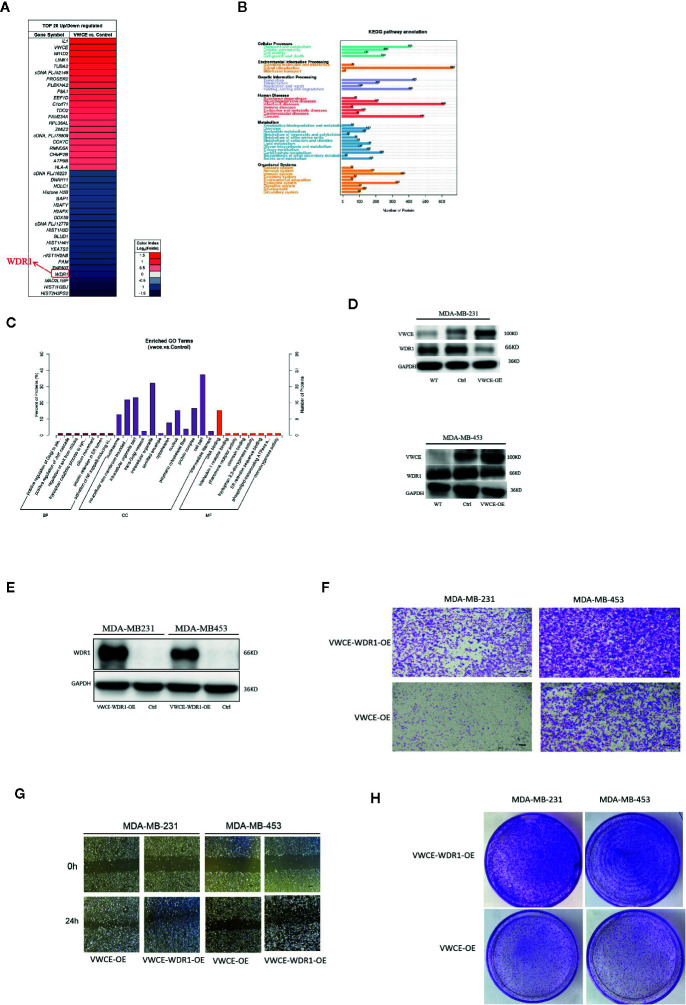
Overexpression of WDR1 partially reversed the tumor-suppressor role of Von Willebrand factor C and EGF domain (VWCE) in breast cancer cells. Identification of differentially-expressed proteins (DEPs) between VWCE overexpression and control groups using an iTRAQ-based proteomic analysis. (A) A heat map showing the DEPs between VWCE overexpression (231-VWCE) and control (231-Contorl) groups of breast cancer cell lines. Blue represents lower levels of protein expression and red represents higher levels of expression compared to the control. (B) A KEGG pathway analysis of the DEPs. (C) A GO analysis of the DEPs. (D) Relative expression of VWCE and WDR1 in MDA-MB-231 and MDA-MB-453 cell lines by Western blot. (E) Western blot analysis of WDR1 protein expression in MDA-MB-453-VWCE, and MDA-MB-231-VWCE cells were stably transfected with the WDR1-overexpressing or negative control lentiviruses. GAPDH was used as a loading control. (F) The impact of WDR1 overexpressionon cell invasion in MDA-MB-453 and MDA-MB-231 cell lines using a transwell assay(scale bar =100 μM). (G) The impact of WDR1 overexpression on cell migration in MDA-MB-453 and MDA-MB-231 cell lines using a wound healing assay (scale bar =100 μM). (H) The impact of WDR1 overexpression on cellular proliferation in MDA-MB-453 and MDA-MB-231 cell lines using a plate cell colony formation assay.